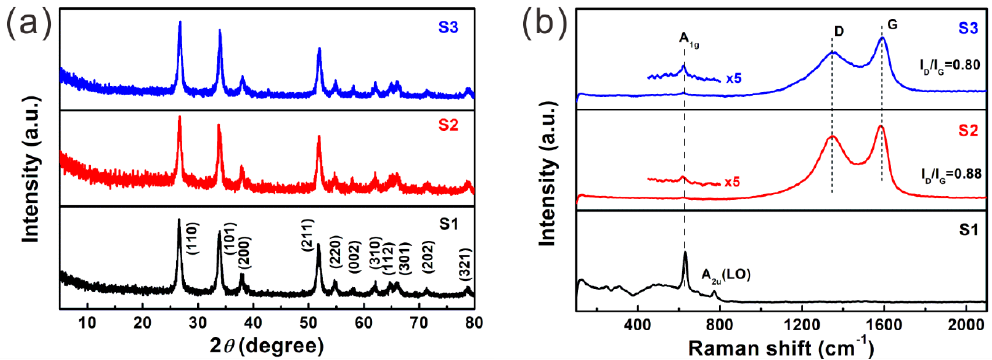
Figure 2. XRD pattern ( a ) and Raman spectra ( b ) of S1 − S3.